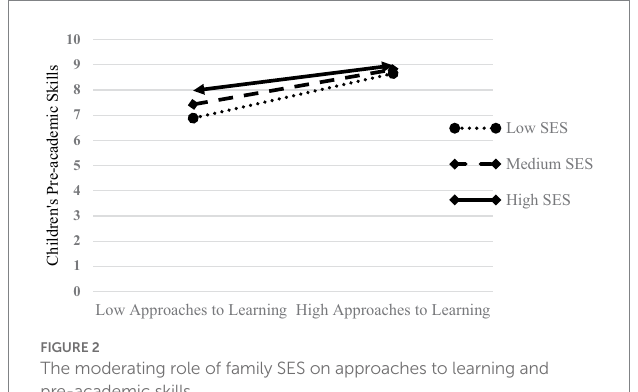
FIGURE 2 The moderating role of family SES on approaches to learning and pre-academic